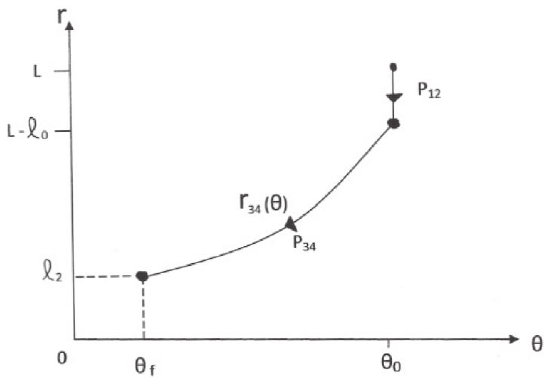
Figure 2: The dynamics of the venepuncture action, following the top of the needle (the TN-point, item 12 of Fig. 1) summarised in polar